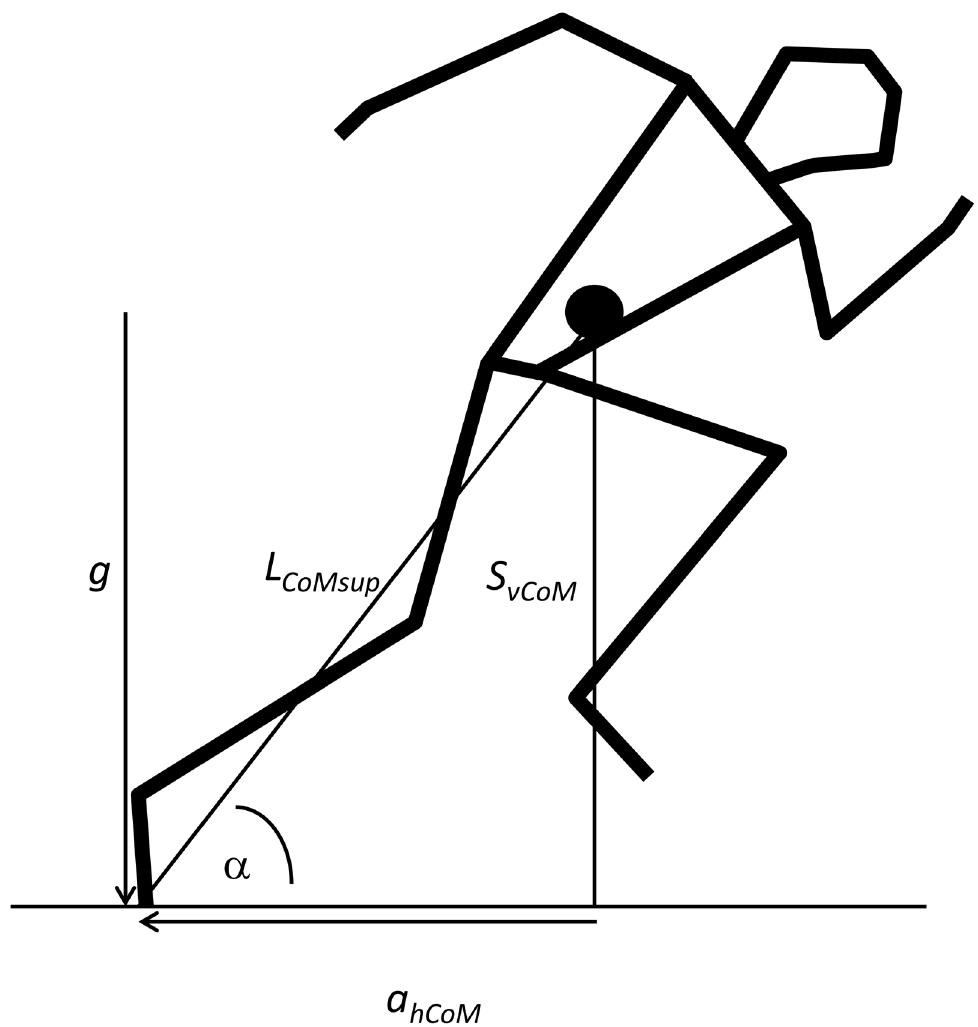
Fig 1. Schematic drawing of a position during accelerated running. The variables described in eqs 1 – 3 and their interrelationships are graphically presented. Accelerations g and a hCoM are defined as by di Prampero et al. [6]. Solid circle is